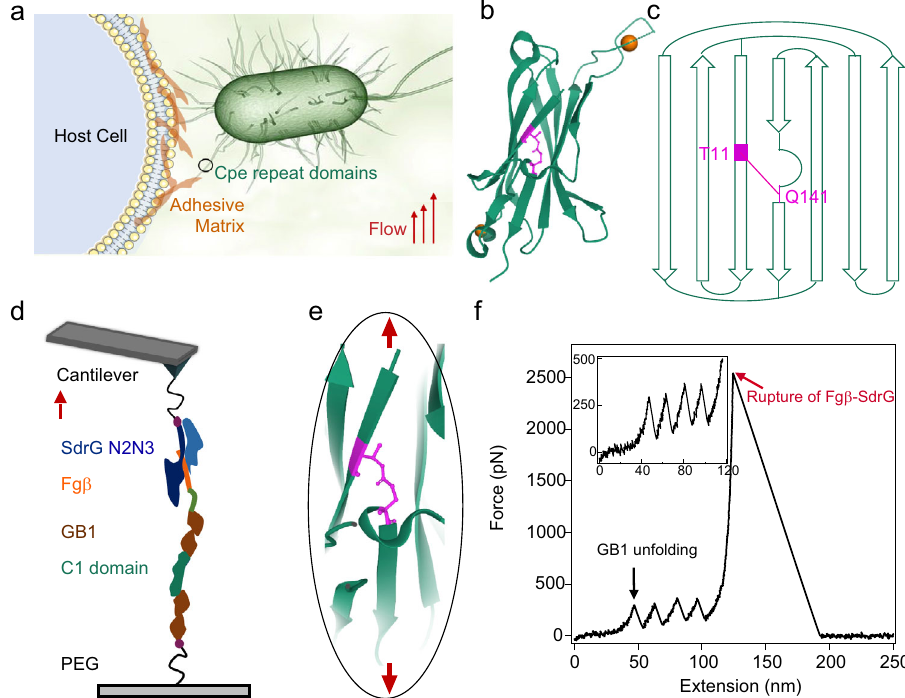
Fig. 1 Cpe0147 is highly resistant to mechanical forces. a Cpe0147 links the tip adhesion domain and bacteria to establish invasion and colonization and experiences considerable mechanical forces in the biological settings. b Structure of the C1 domain from PDB (4MKM). The ester bond is highlighted in magenta and the two calcium ions are shown as orange spheres. c Topology of C1 WT domain. The ester bond is formed between Thr-11 and Gln-141. d Schematic of the AFM-based single-molecule force spectroscopy experiments. Fg β -(GB1) 2 -C1 WT -(GB1) 2 -cys was covalently anchored to a glass surface through a polyethylene glycol (PEG) linker via thiol – maleimide chemistry and picked up using a SdrG-cys modi fi ed cantilever. e Mechanical extension of C1 WT from its N- and C-termini is blocked by the ester bond as the ester bond is located right at the force concentration point. f A representative single- molecule force – extension trace at 1.6 μ m s − 1 showing the unfolding of the four GB1 domains (black arrow) at ~200 pN but no unfolding peak of C1 WT up to the rupture forces of Fg β -SdrG complexes (red arrow). This experiment was repeated more than six times independently with similar results. Source data are provided as a Source Data fi